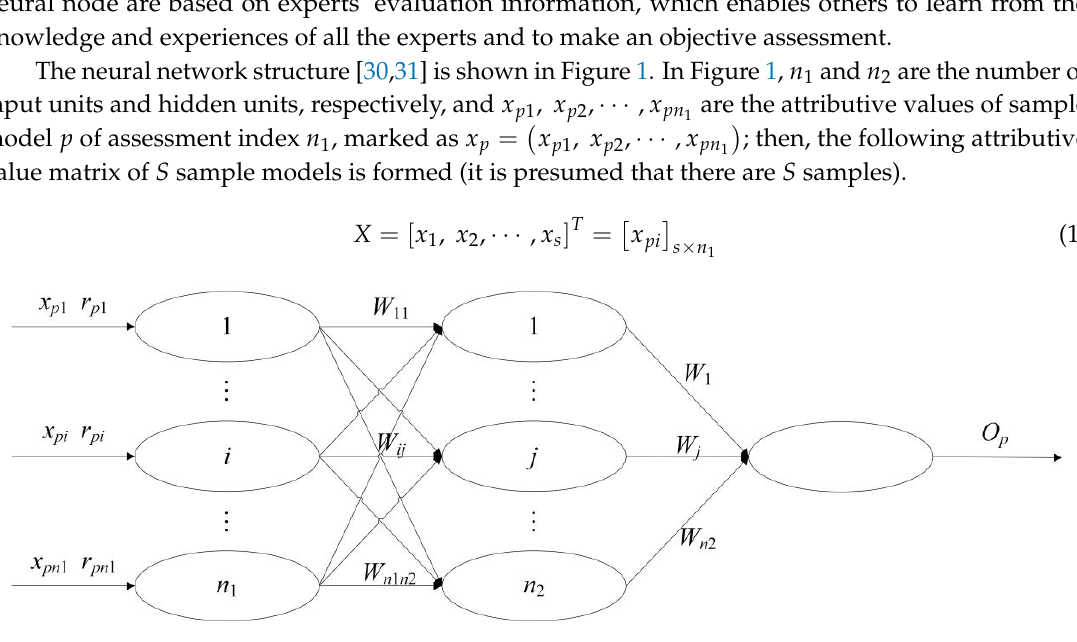
Figure 1. Comprehensive assessment model of the neural network.